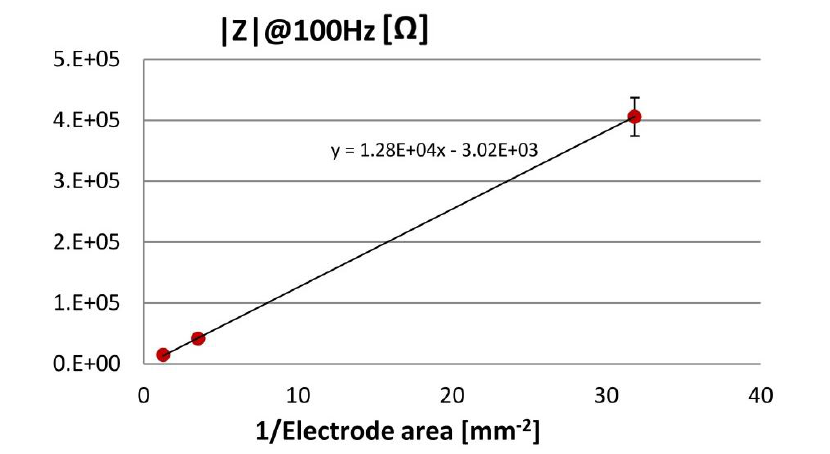
Figure 13. Impedance magnitude values at 100 Hz derived from the data of Figure 12, plotted against the inverse values of the electrode area (mean ± SD).